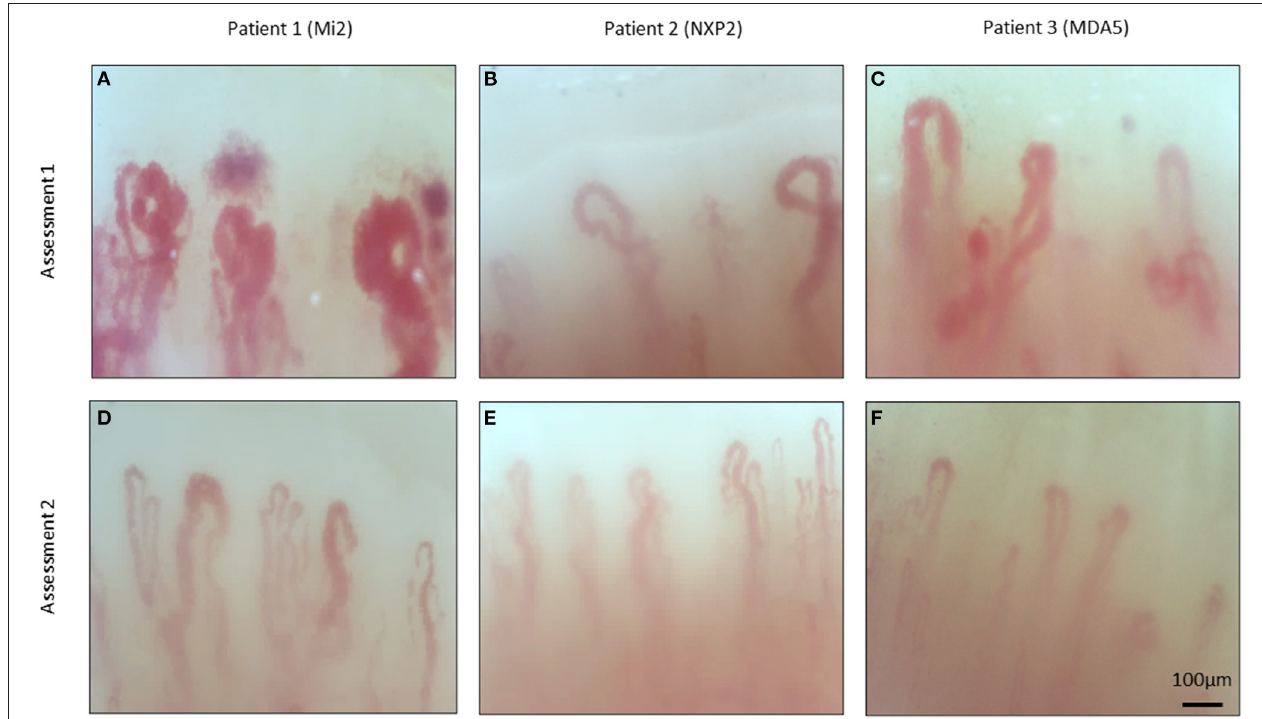
FIGURE 1 | Nailfold video capillaroscopy images of three patients with dermatomyositis. Representative images of three patients with dermatomyositis taken during serial assessments. Myositis specific antibodies indicated in brackets. Abnormal features include presence of dilated capillaries (A–D) , microhemorrhages (A,C) , decreased capillary density (A–D) , and do not demonstrate and gross abnormalities (E,F)